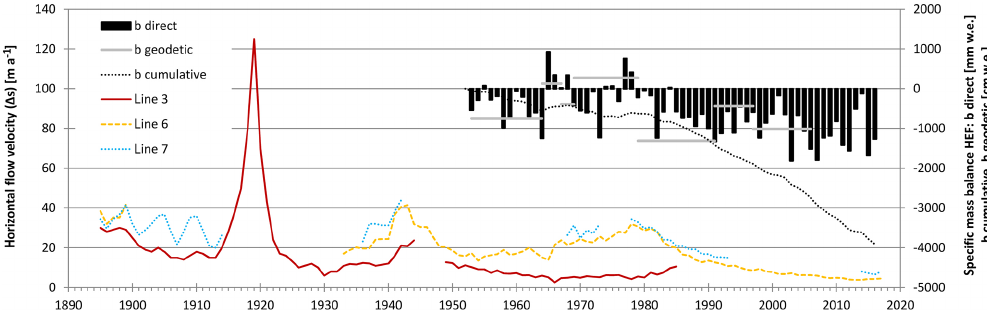
Figure 3. The mean annual velocities of the stones at lines 3, 6 and 7 on Hintereisferner since 1894/95 ( = 1895). The data series has been extended since Span et al. (1997) and annual specific surface mass balance (b direct) (Strasser et al., 2018; WGMS, 2017; original data: Hess, 1924), as well as the geodetic balances from DODs (b geodetic) by Fischer (2011) since 1953. Locations of the stone lines are shown in Fig. 1.